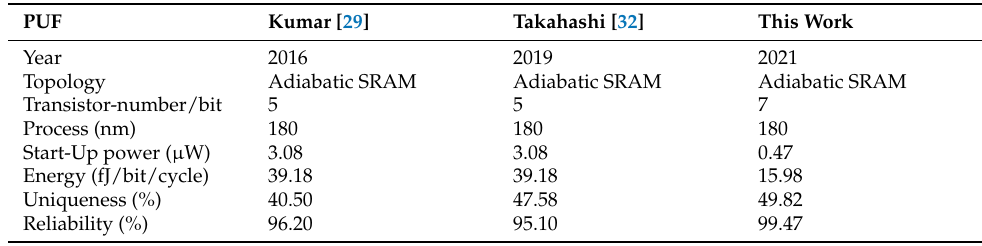
Table 2. Comparison of conventional and proposed adiabatic PUFs (with T = 27 ◦ C and C L = 10 fF, f Cb = 10 MHz, and f Vpc = 100